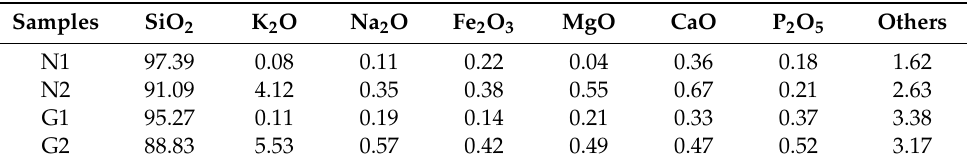
Table 1. Chemical composition of di ff erent types of RHA